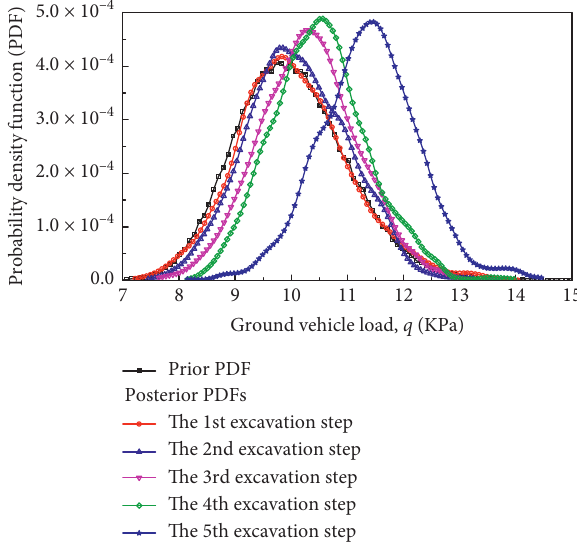
Figure 8: Comparison of the posterior PDFs of ground vehicle load for different excavation steps.